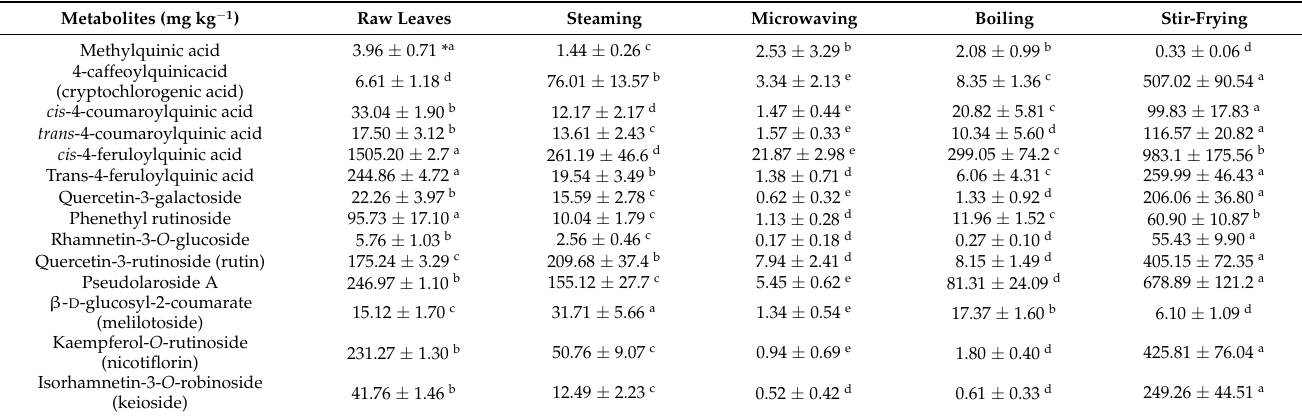
Table 1. Impact of different household cooking techniques on the bioactive metabolites of African pumpkin leaves ( Momordica balsamina